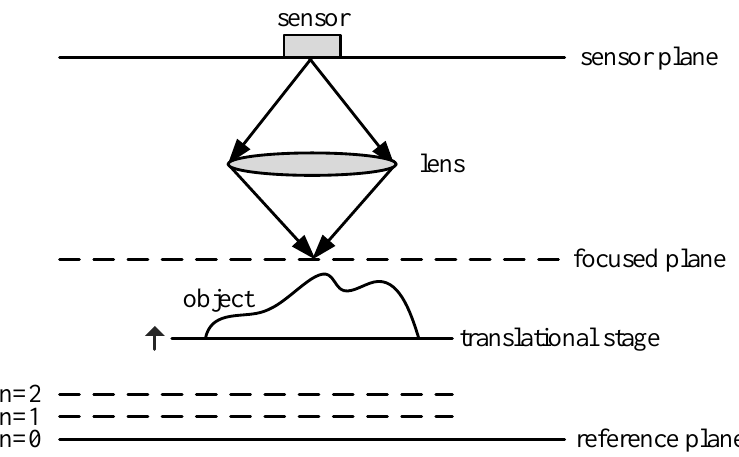
Figure 1. Principle of image sequence acquisition in shape from focus